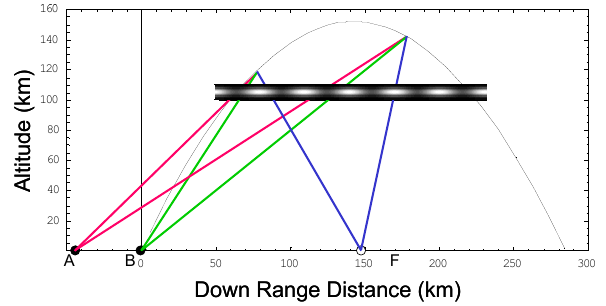
Figure 11. Test example for tomographic reconstruction of a thin layer. The points (A, B) are the actual receiver locations at Tarumizu and Uchinoura during SEEK2. The point F is a “fictitious” receiver located in the sea off the coast of Japan.